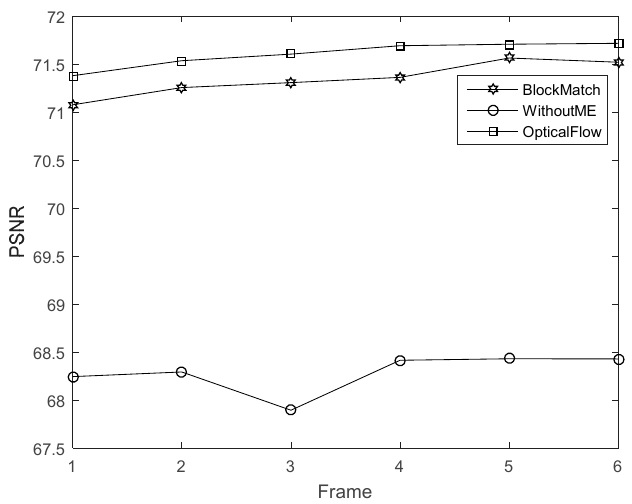
Figure 13. ( a ) The images from the second sample video; ( b ) The video recovered by traditional compressive sensing algorithm; ( c ) The video is recovered by CS-MUVI; ( d ) The video is recovered using our proposed block match motion estimation.